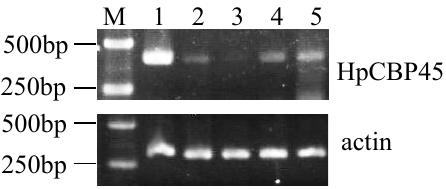
Figure 6. RT-PCR analysis of HpCBP45 in different tissues.